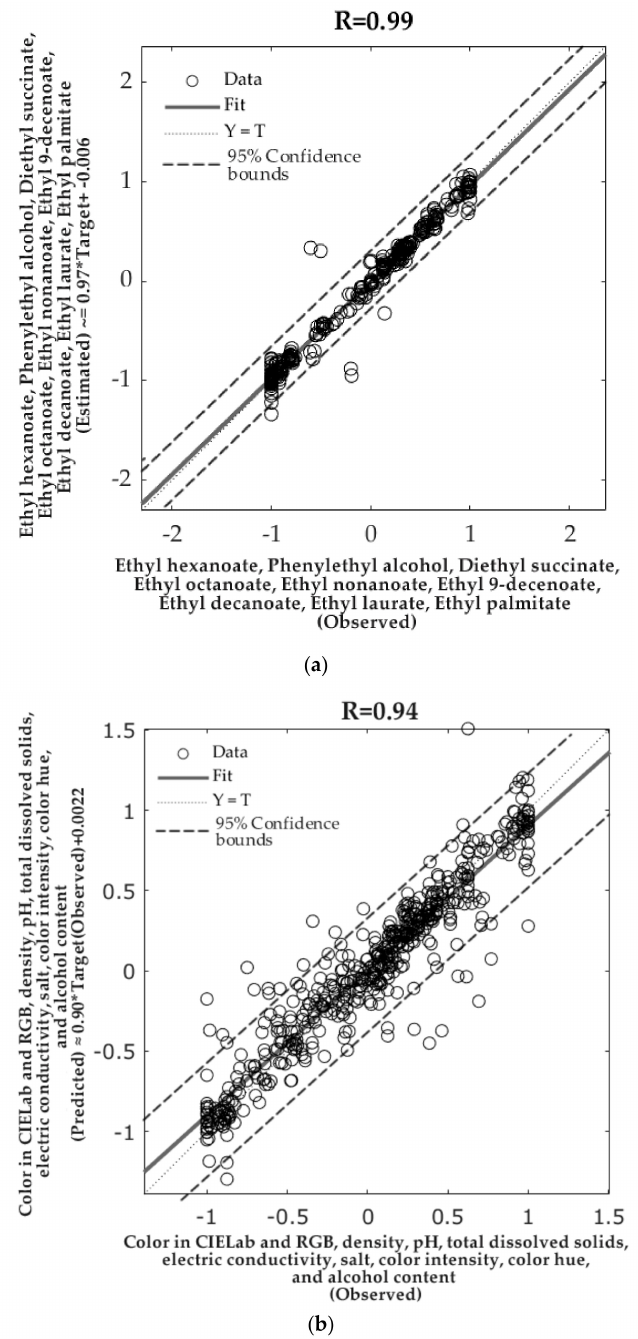
Figure 4. Overall artificial neural network models to predict ( a ) the aroma profile (Model 1) and ( b ) the physicochemical parameters of Pinot noir wines (Model 2), both using the weather data as inputs (Figure 2). The models show the observed (x-axis) and predicted (y-axis) data as well as the 95% confidence